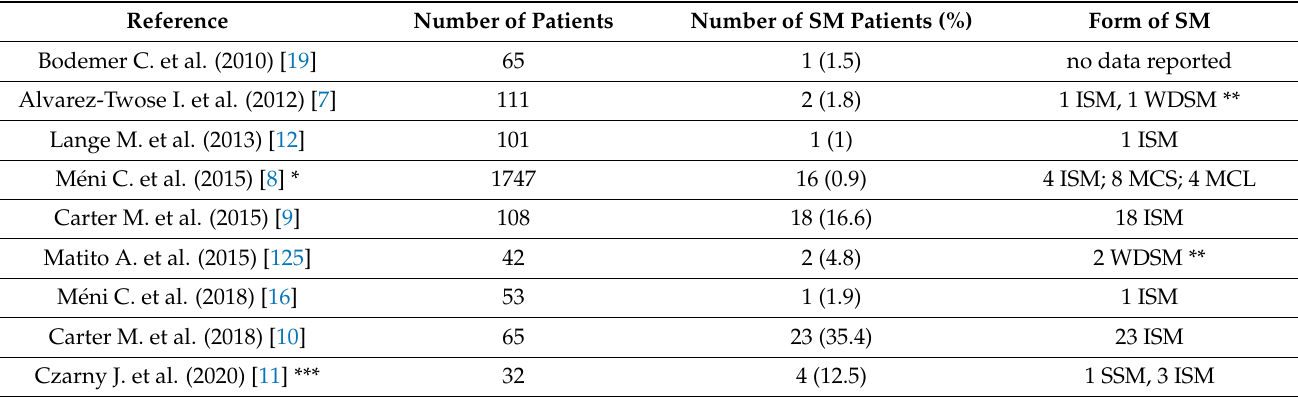
Table 2. SM reported in studies on selected groups of pediatric patients with